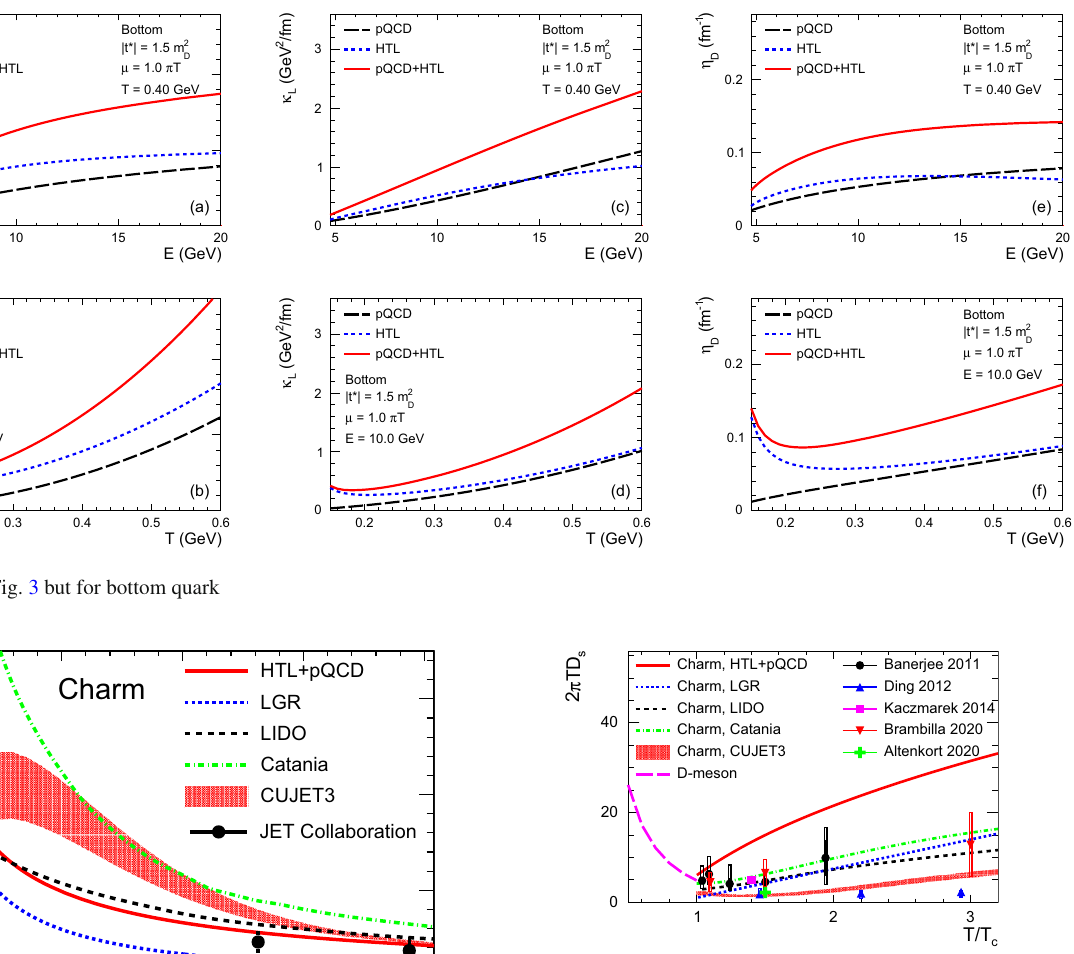
Fig. 6 Spatial diffusion constant 2 π T D s ( T ) of charm quark from the soft-hard scenario (solid red curve), LGR (dotted blue curve [40], LIDO(dashedblackcurve[60]),Catania(dot-dashedgreencurve[61]), CUJET3 (shadowed red band [18,20,21]) and lattice QCD calculations (black circle [64], blue triangle [65], pink square [66], red inverted tri- angle [67] and green plus [68]). The result for D-meson (long dashed pink curve [69]) in the hadronic phase is shown for comparison √ s NN = 2 . 76 TeV, respectively. The calculations are done with FONLL initial charm quark spectra and EPS09 NLO parametrization for the nPDF in Pb [27], and the pink band reflects the theoretical uncertainties coming from these inputs. It can be seen that, within the experimental uncer- tainties, the model calculations provide a very good descrip- tion of the measured p T -dependent R AA data for various charm mesons. Concerning the results in Pb–Pb collisions √ s NN = 5 . 02 TeV, as shown in Fig. 8, a good agree- at ment is found between the model and the measurement at p T (cid:3) 6 GeV / c , while a slightly larger discrepancy observed at larger p T . Figure 9 presents the elliptic flow coefficient v 2 of non- strange D-meson (averaged D 0 , D + , and D ∗+ ) in